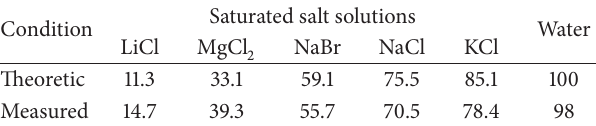
Table 4: Humidity control for isotherm adsorption test/%.